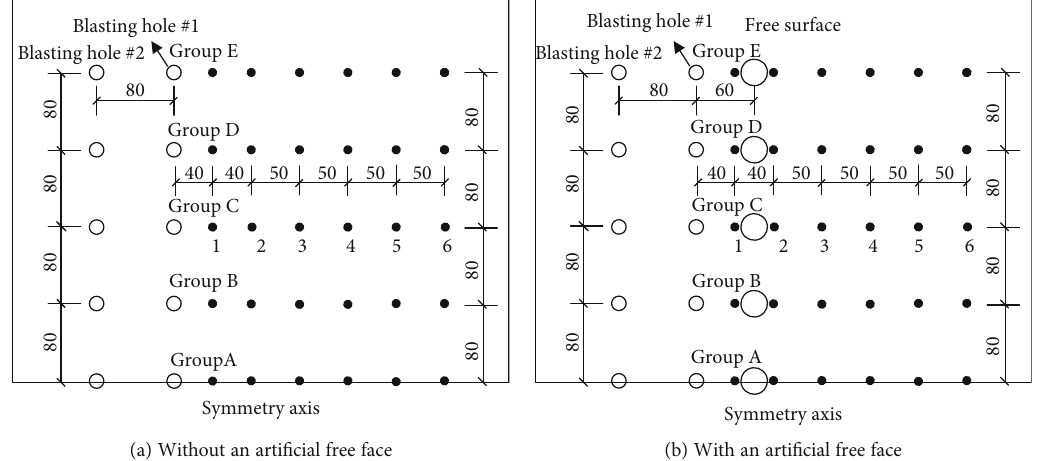
Figure 15: Schematic diagram of the selected surface